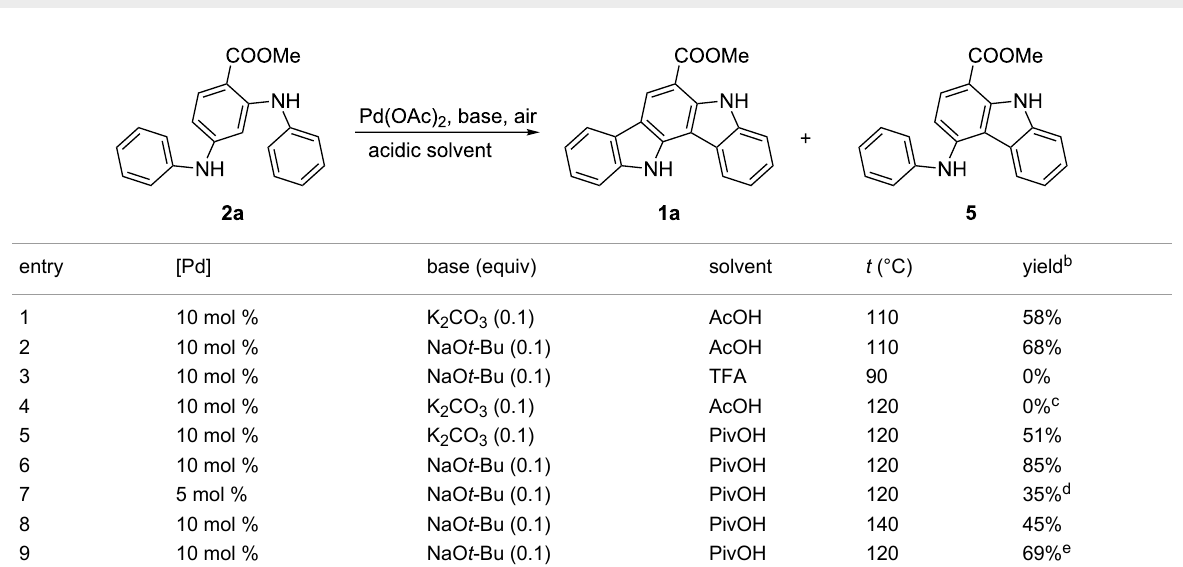
Table 1: Optimization studies for annulation conditions.